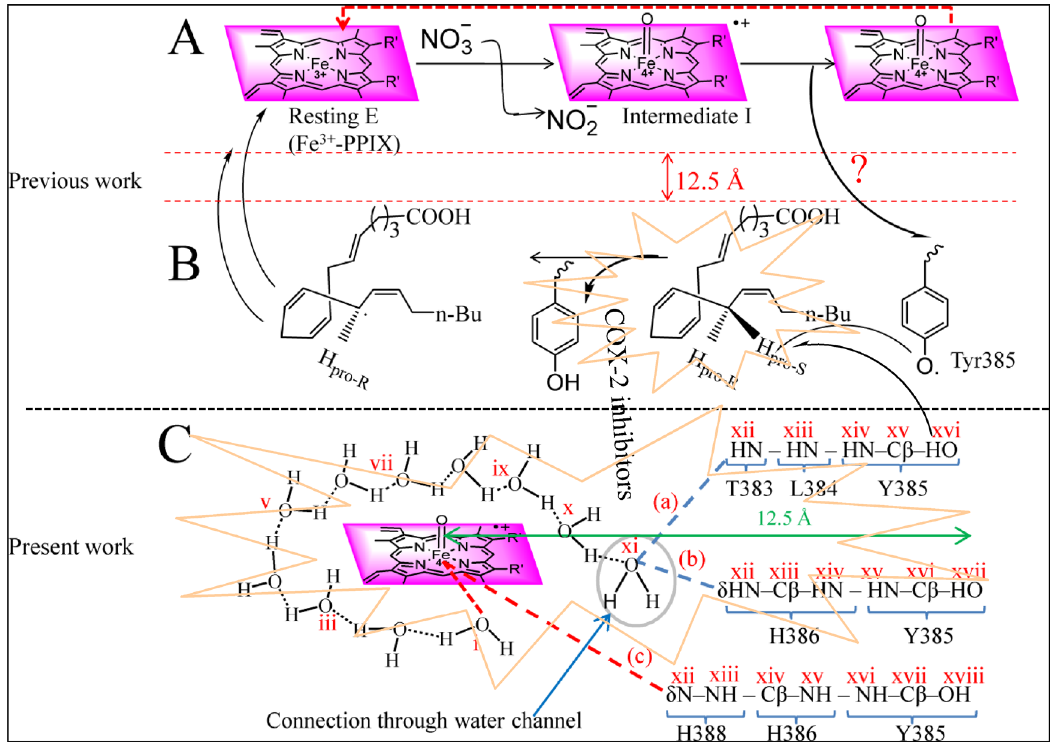
Figure 1. Cyclooxygenase catalysis: Reported working of COX-1/2 showing radical ( A ) at heme and its transfer ( B ) to Y385. ( C ) ‘a’, ‘b’: proposed electron transfer route (labelled i-xvi/xvii/xviii) through H-bonded water loop and the peptide; ‘c’: direct interaction of ferryl heme with the peptide. The stars represent the action of reported COX-2 inhibtors in ( B ) the arachidonic acid (AA) binding pocket and ( C ) the proposed plan for covering the heme and the AA binding pockets